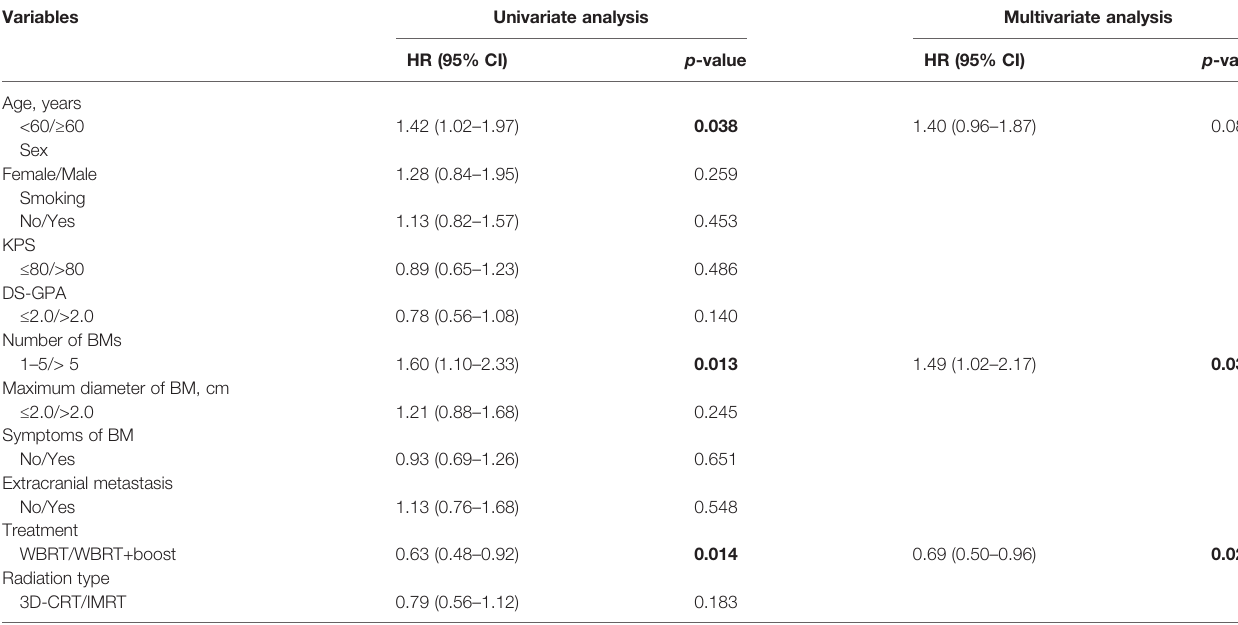
TABLE 2 | Univariate and multivariate analyses of factors in fl uencing OS of 180 SCLC patients with BM. Variables Univariate analysis Multivariate analysis